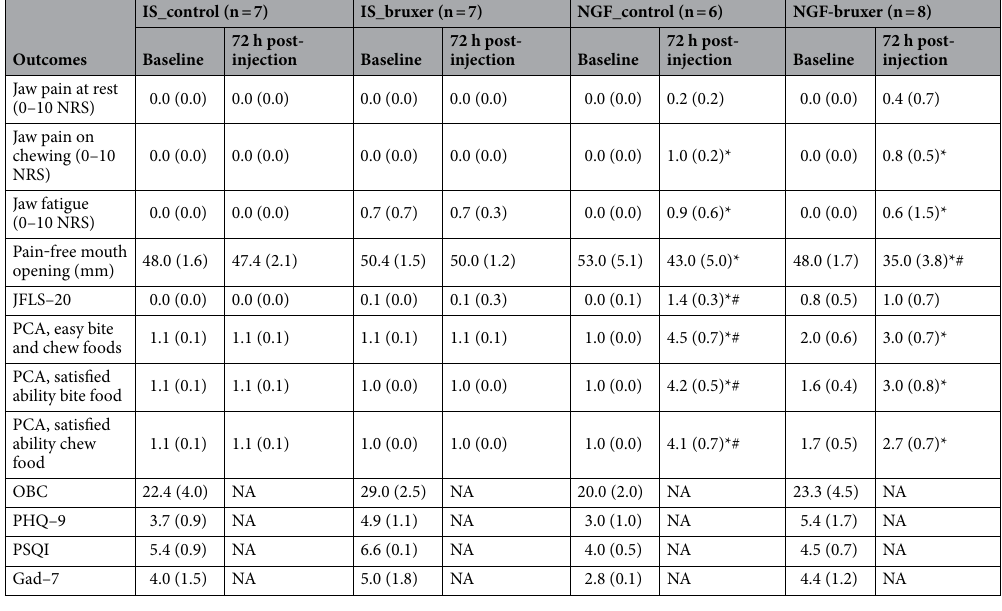
Table 1. Clinical assessment of jaw pain and function and psychological and sleep conditions at baseline and 72 h after the intramuscular administration of either isotonic saline (IS) or nerve growth factor (NGF). (*) In the same row indicates significant higher within-group differences (Baseline and after injection and OMT) considering bruxer and control participants that received IS or NGF following pairwise post hoc comparisons ( P < 0.01). (#)The same column indicates significant between ‐ group differences following pairwise post hoc comparisons ( P < 0.05). JFLS–20 Jaw function limitation scale–20, PCA Perceived chewing ability, OBC Oral behavior checklist, PSQI Pittsburgh sleep quality index, GAD–7 Generalized anxiety disorders,